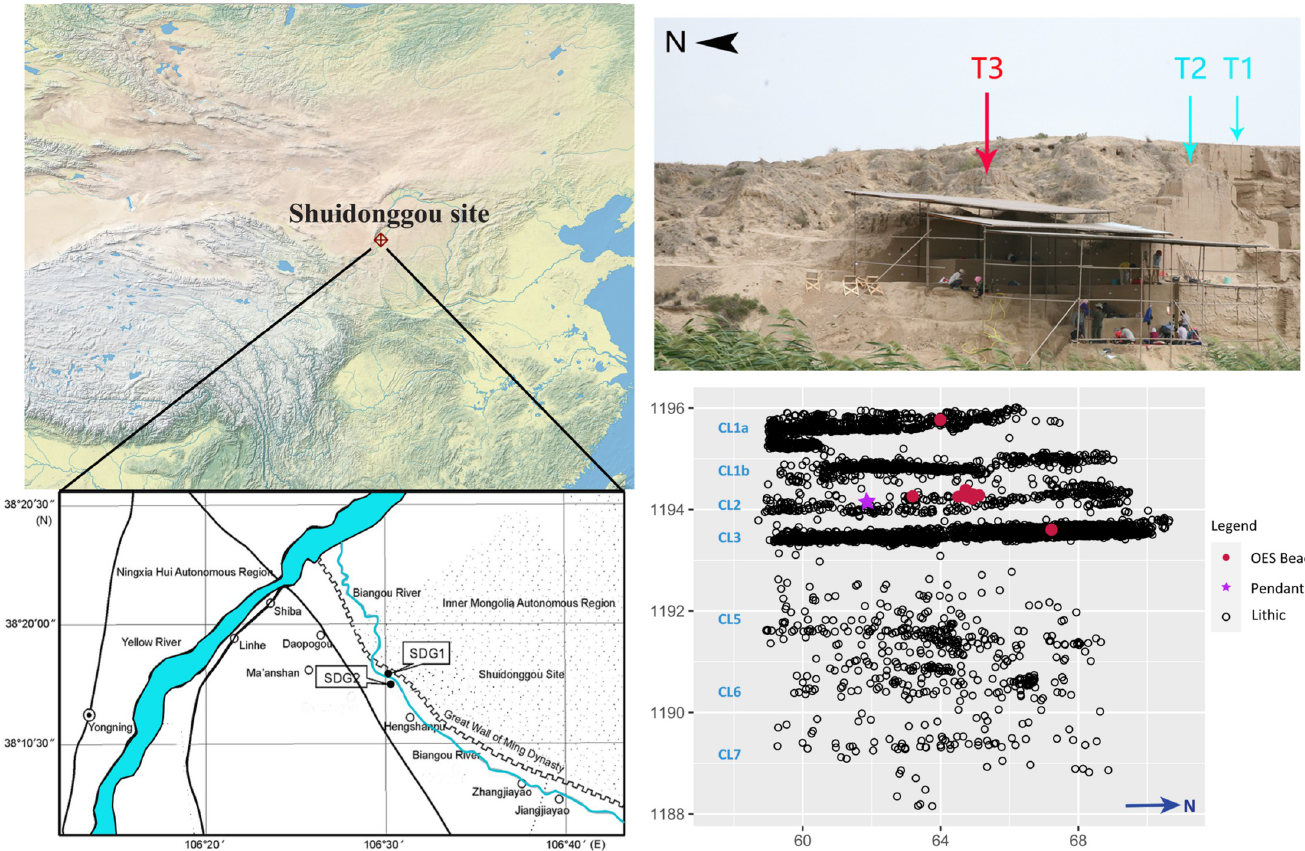
Fig 2. Location of Shuidonggou Locality 2 and cultural layers (adapted from [30, 50]).